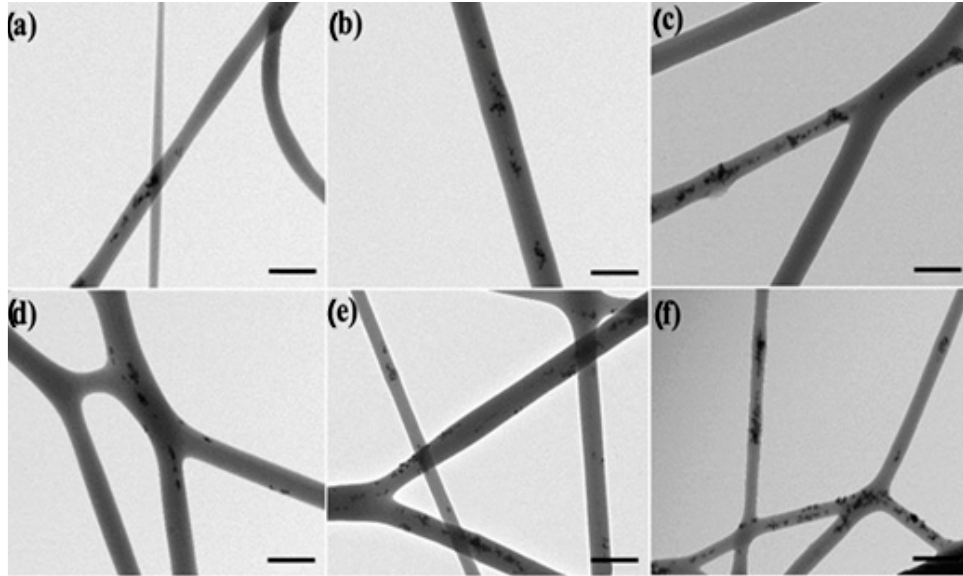
Figure 5. Comparison of the nanoparticles dispersion within the electrospun poly(3-hydroxybutyr- ate-co-3-hydroxyvalerate) (PHBV) fibers: ( a ) 0.5 wt.% CeO 2 NPs + CTAB; ( b ) 1.0 wt.% CeO 2 NPs + CTAB; ( c ) 1.5 wt.% CeO 2 NPs + CTAB; ( d ) 2.0 wt.% CeO 2 NPs + CTAB; ( e ) 5.0 wt.% CeO 2 NPs + CTAB; ( f ) 10.0 wt.% CeO 2 NPs + CTAB. Micrographs were taken by transmission electron microscopy (TEM). Scale bar 400 nm.